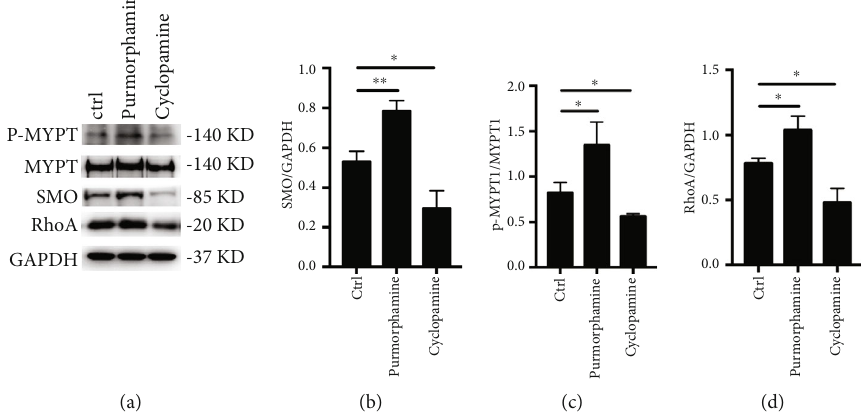
Figure 3: Smo agonist and antagonist regulate the expression of Rho/ROCK-related proteins. (a) The expression of p-MTPT1, MTPT, RhoA, and Smo was detected by western blot. (b) The relative expression of Smo was upregulated in the treatment of purmorphamine, and it was downregulated by using cyclopamine. (c) The phosphorylation level of MYPT-1 was upregulated in the treatment of purmorphamine, and it was downregulated after adding cyclopamine. (d) The relative expression of RhoA was upregulated in the treatment of purmorphamine, and it was downregulated by using cyclopamine. ∗ p < 0 : 05 , ∗∗ p < 0 : 01